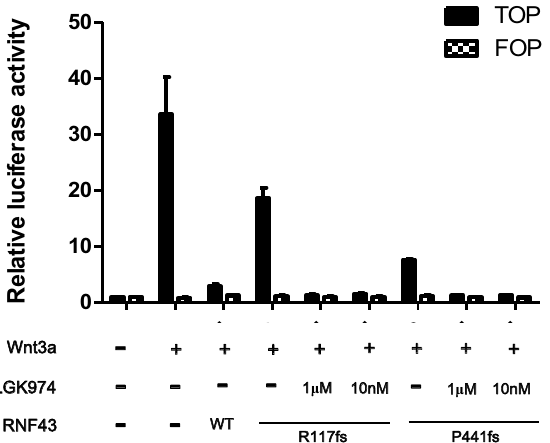
Figure 2. LGK974 inhibits the enhanced Wnt/β-catenin signaling pathway activity induced by R117fs and P441fs mutants. LGK974, a highly specific and potent Porcupine inhibitor, effectively inhibited Wnt/β-catenin signaling at a low concentration of 10